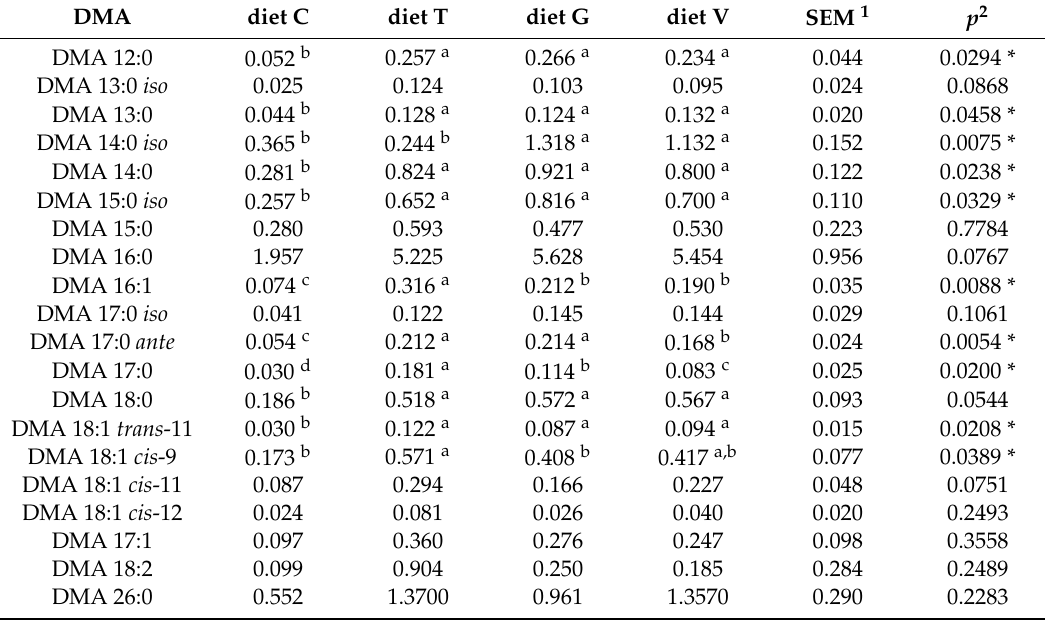
Table 2. Profile of identified dimethyl acetals (DMA) in rumen liquor at 24 h (g / 100g dry matter